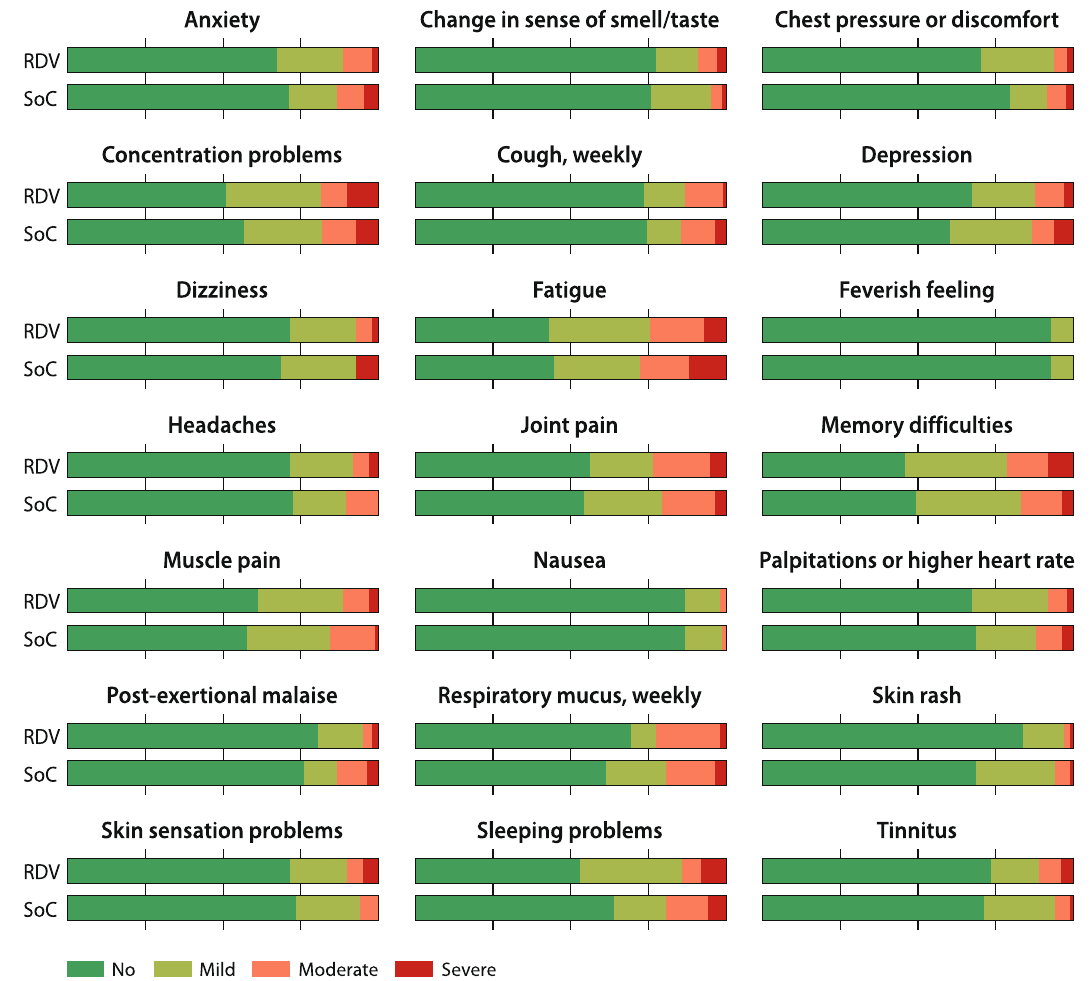
Fig. 2 | Botherfrompotential long-COVID symptomsat1 yearfrom COVID-19hospitalization betweenthe standard of care and standard ofcare plus remdesivir groups. RDV stands for remdesivir plus standard of care group, and SoC for standard of care